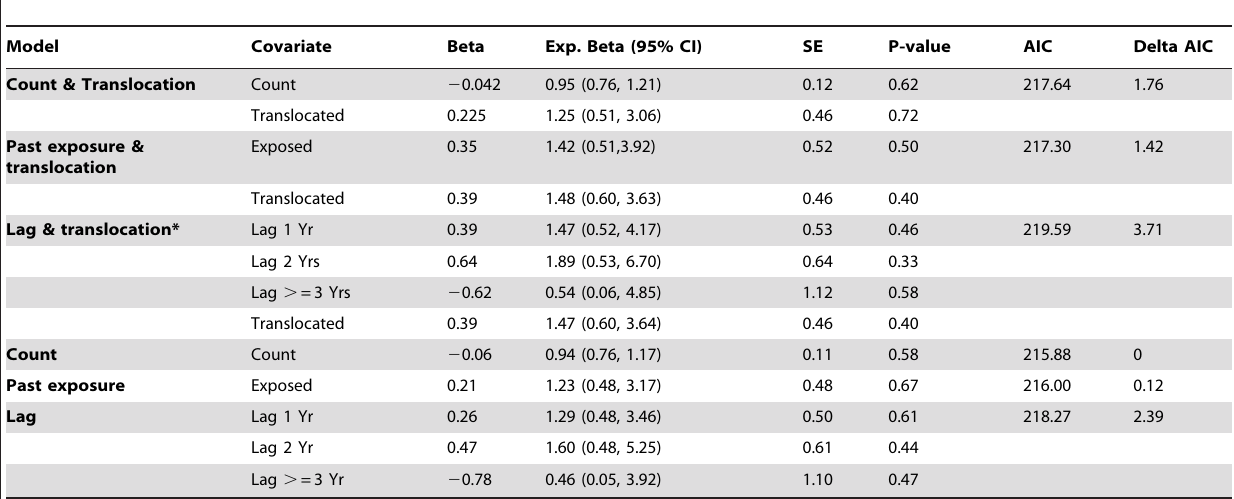
Table 4. Ewes in non-pneumonia (healthy) years: impact of covariates on the relative risk of dying (of causes other than pneumonia) outside of pneumonia